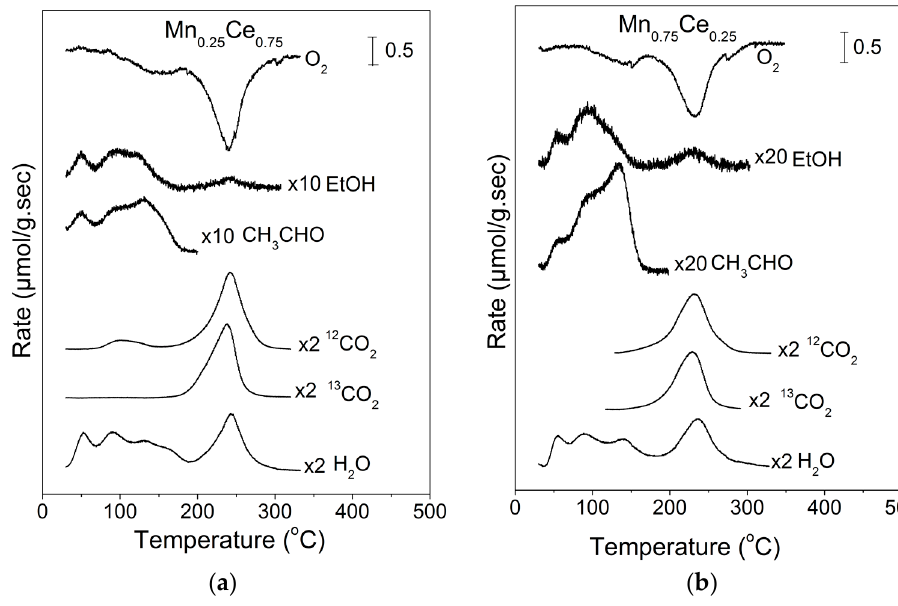
Figure 4. ( a ) TPO profiles following 12 CH 313 CH 2 OH adsorption on Mn 0.25 Ce 0.75 catalyst, ( b ) TPO profiles following 12 CH 313 CH 2 OH adsorption on Mn 0.75 Ce 0.25 catalyst. Table 2. Product distribution during ethanol ‐ TPO over Mn x Ce 1 − x catalysts. EtOH (%) CH 3 CHO (%) CO 2 (%) CeO